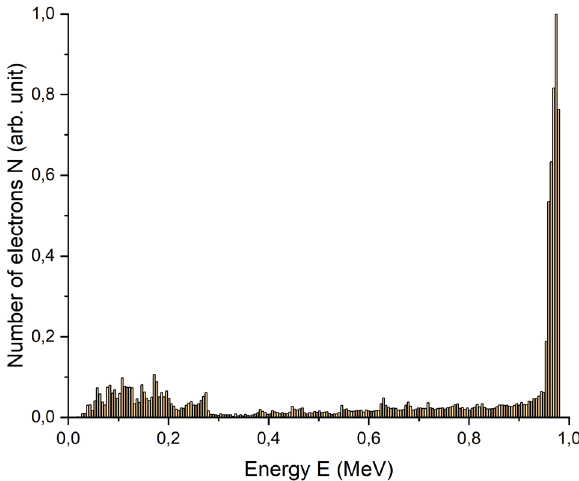
Figure 1. The electron spectrum N(E) of the accelerator UELR-1-25-T-001.